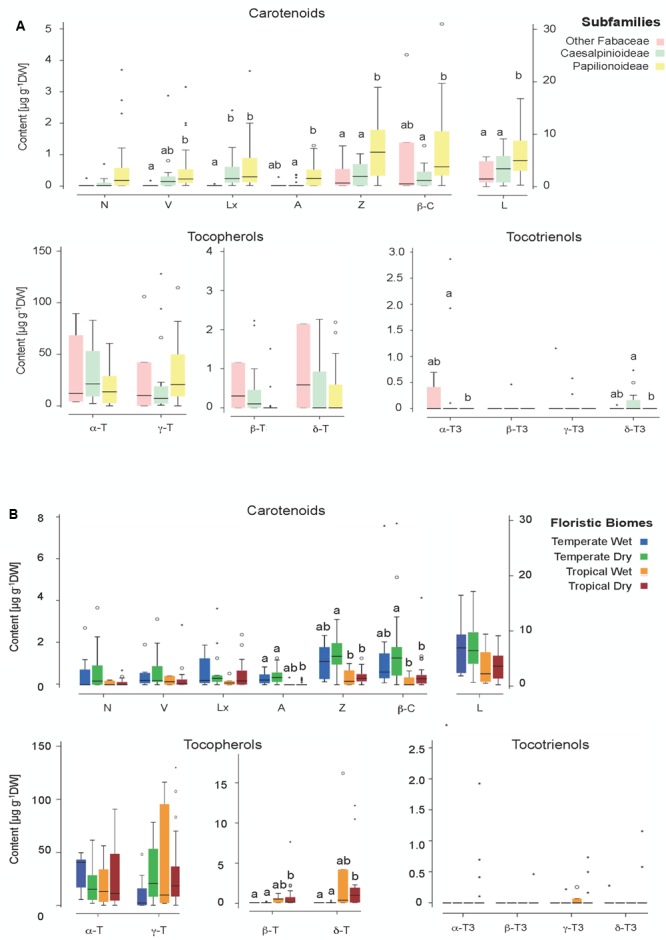
Box plot illustrating the contents of individual metabolites for (A) different phylogenetic groups (subfamilies) and (B) different floristic biomes (details in Supplementary Table S1). Boxes cover 50% of the data. Central lines represent the medians and whiskers represent the minimum and maximum values among non-atypical data. When significant, differences among categories are indicated with letters (P < 0.05).